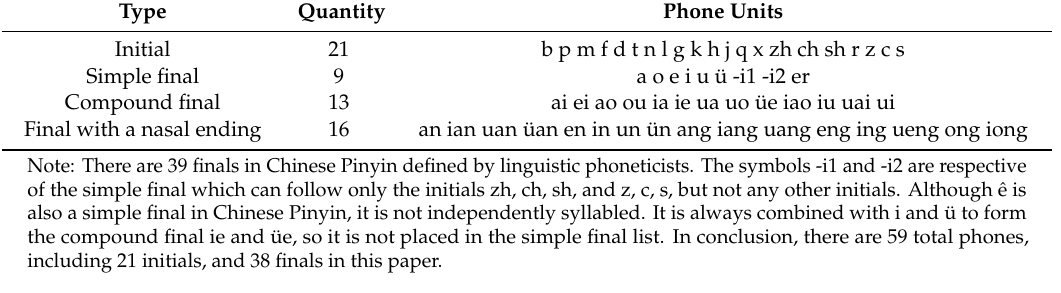
Table 2. Number of sentences of announcers in China Central Television (CCTV) news speech